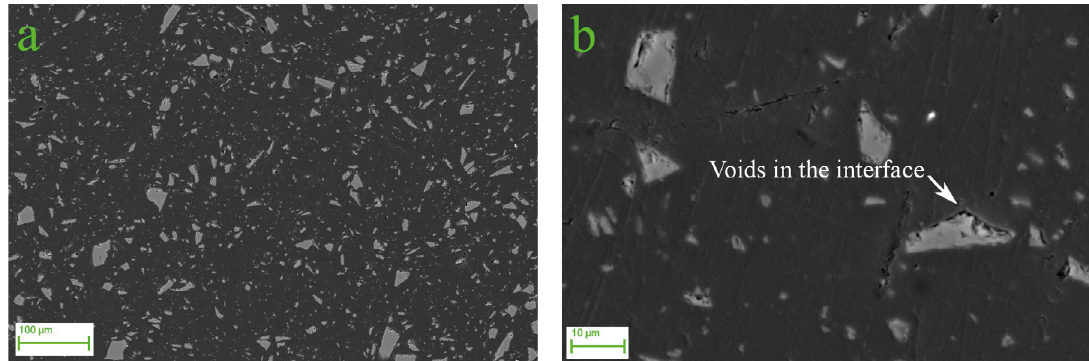
Figure 10. SEM microphotograph of a sample containing 20% (wt) crystalline silica Bars: A - 100 µm; B - 10 µm